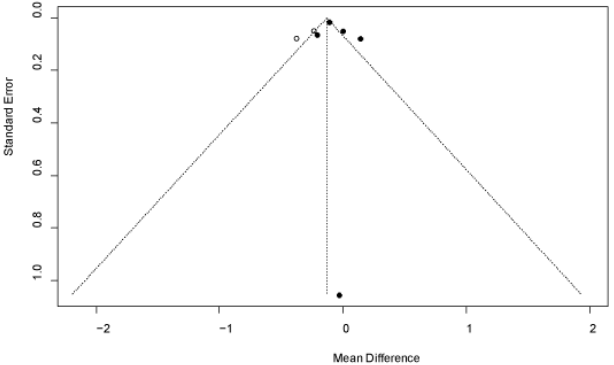
Figure 3. Sensitivity analysis of meta-analysis with a random effects model for the association between improvement of lung function parameters and the LTC4S-444A/C polymorphism (AA vs. AC (or AC + CC)).